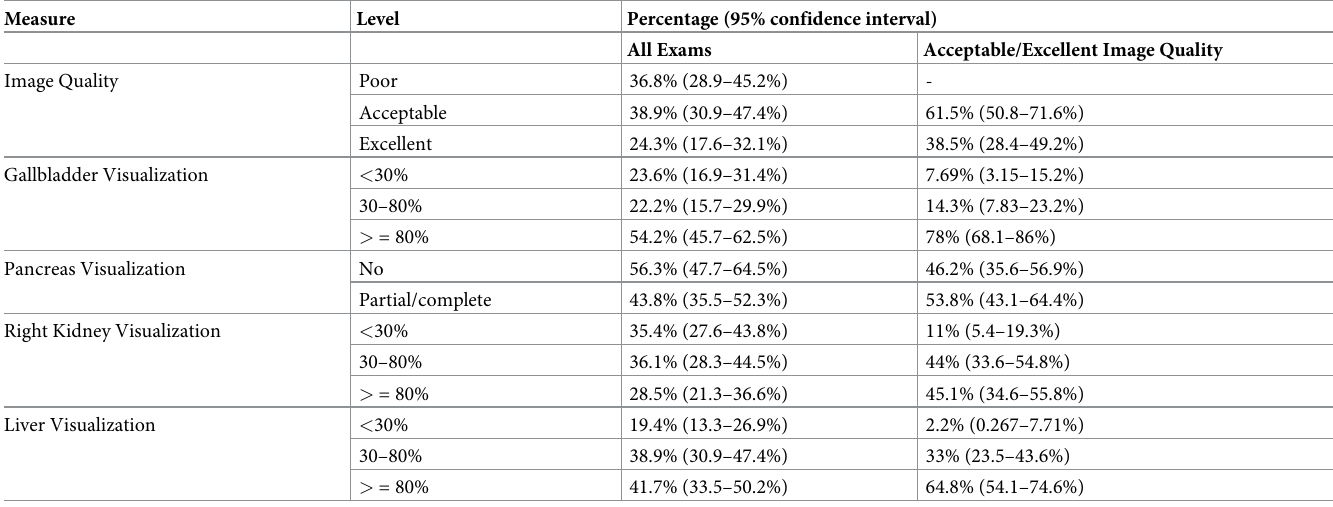
Table 1. Image quality and organ visualization of all